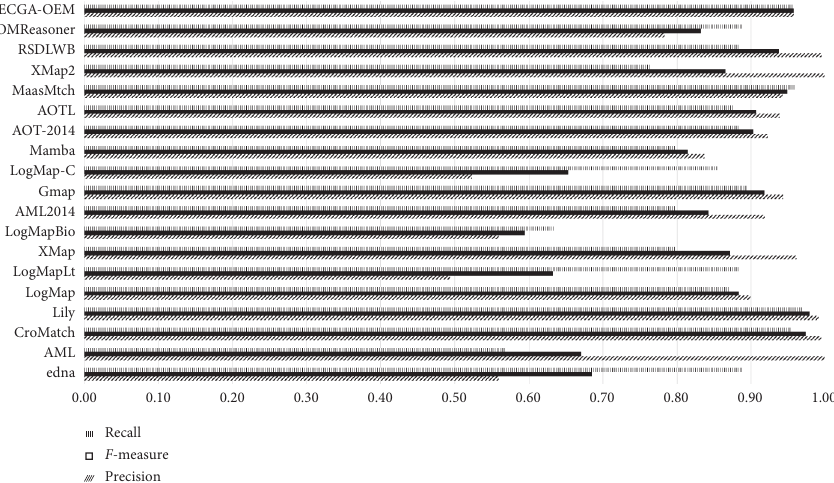
Figure 8: The harmonic mean of OAEI’s participants and ECGA-OEM.